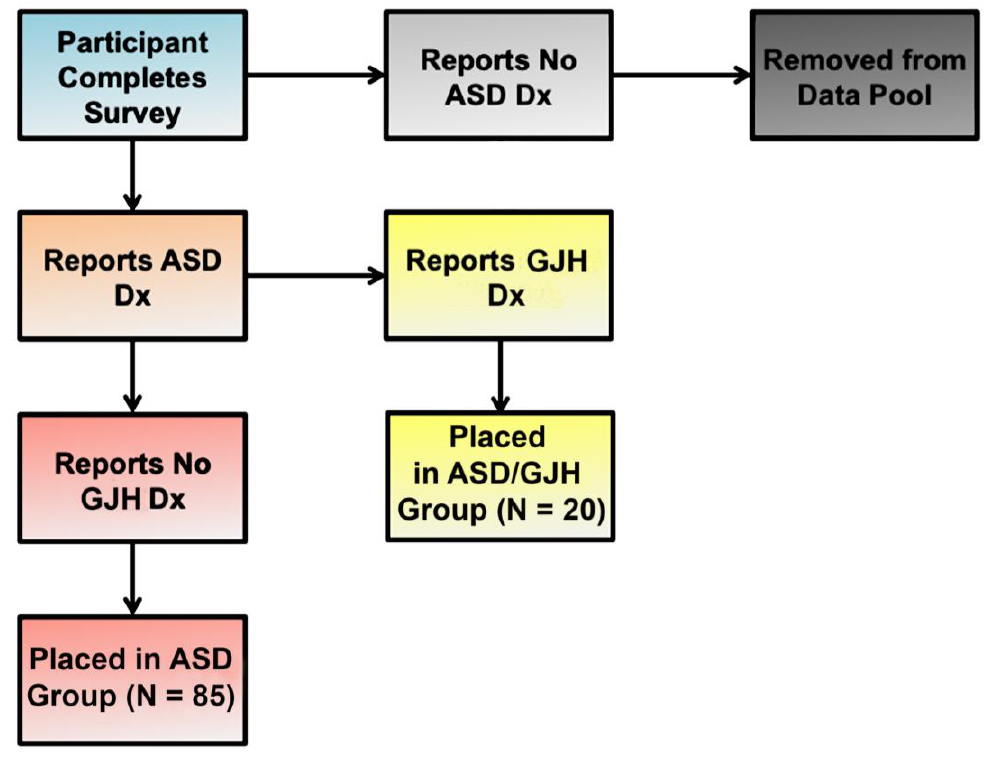
Figure 1. Flow chart illustrating group allocation according to reported diagnoses. Table 1. Terms and diagnoses related to the connective tissue disorders discussed in the manuscript. Generalized Joint Hypermobility-Related